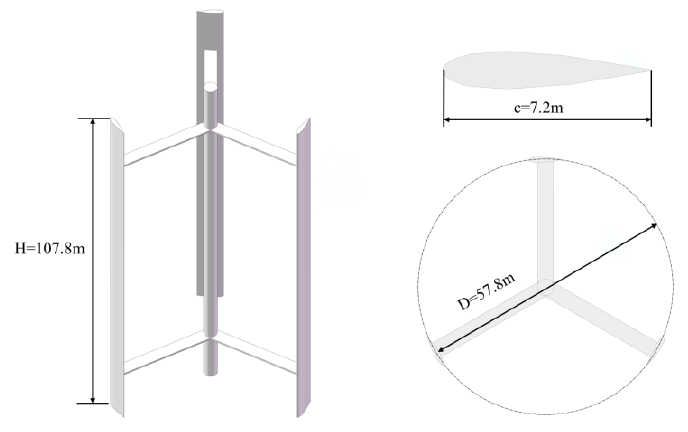
Figure 2. Model diagram of the rotor.